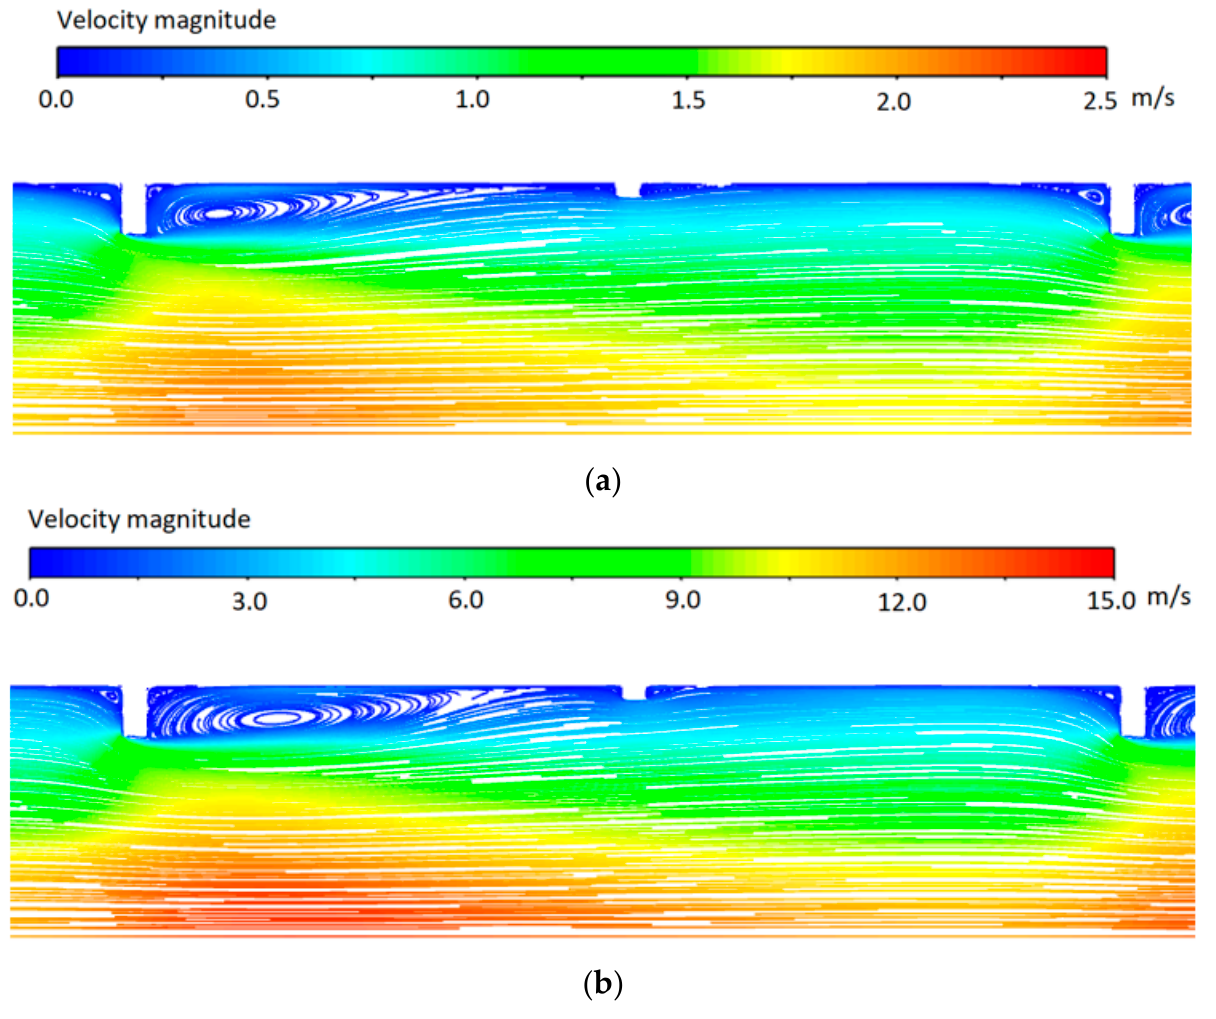
Figure 10. Streamlines and velocity magnitude flow fields between the fifth and seventh ribs of configuration e 2 /e 1 = 0.25, e 1 /d = 0.1, p/d = 1.0, and w/d = 0.05 at Re values of ( a ) 10,000 and ( b ) 60,000.